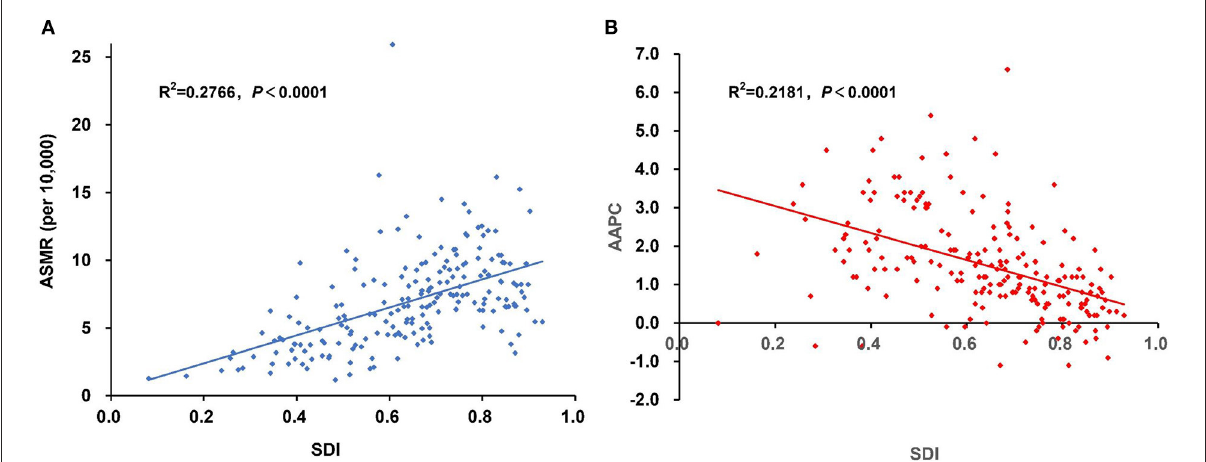
FIGURE2 The association between SDI and the (A) ASMR and (B) AAPC of cancer attributable to high BMI in 2019. Pearson correlation analysis reflected a significantly positive correlation between the ASMR and SDI level, whereas a significantly negative correlation was found between the AAPC and SDI level. AAPC, average annual percentage change; ASMR, age-standardized mortality rate; BMI, body mass index; SDI, Socio-demographic